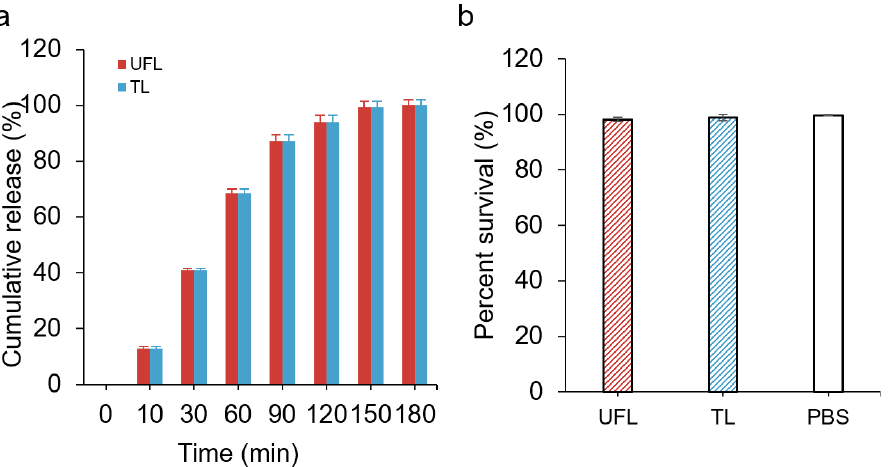
Figure 2. ( a ) Release profiles of UFLs and TLs; ( b ) percentage survival of human keratinocytes treated with UFL, TL, or PBS (negative control) for 24 h.